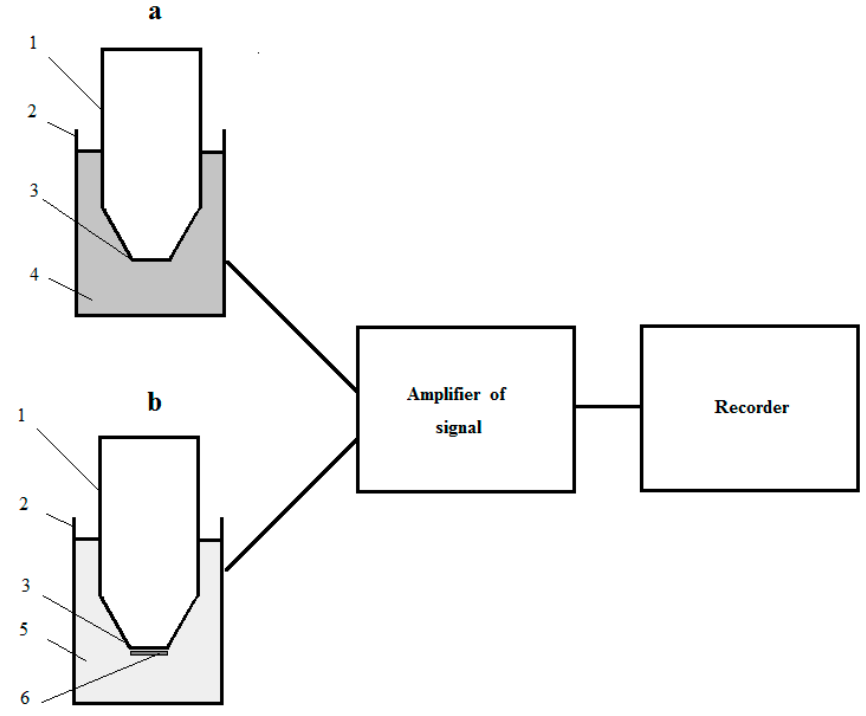
Figure 1. The design of laboratory models of the respiratory-based microbial sensor: ( a ) The recog- nizing part of RMS; ( b ) The recognizing part of MMS; 1—the Clark-type electrode; 2—measuring cell; 3—measuring surface of electrode; 4—suspension of culture-receptor cells in buffer solution; 5—buffer solution; 6—receptor-element (immobilized cells of culture-receptor).